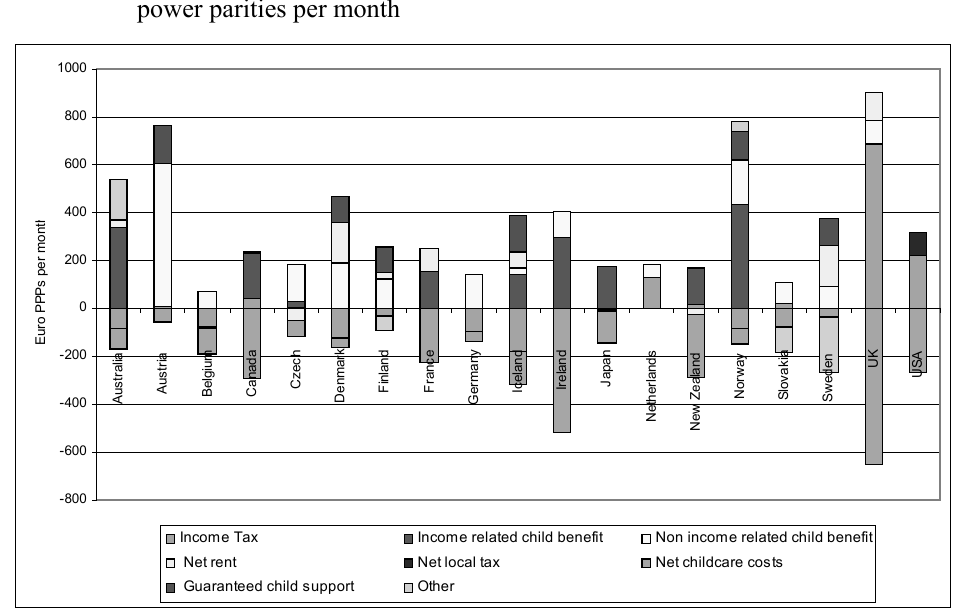
Figure 20 : Structure of the child benefit package for a lone parent with one preschool aged child on half average earnings in January 2004 in Euros purchasing power parities per